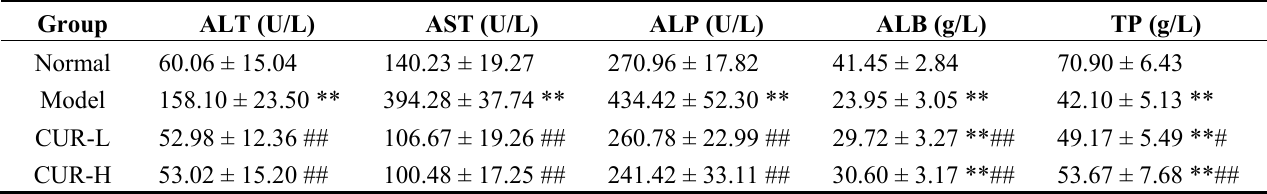
Table 1. Effects of curcumin on serum ALT, AST, ALP, ALB, TP (mean ± SD). Group ALT (U/L) AST (U/L) ALP (U/L) ALB (g/L) TP (g/L) Normal 60.06 ± 15.04